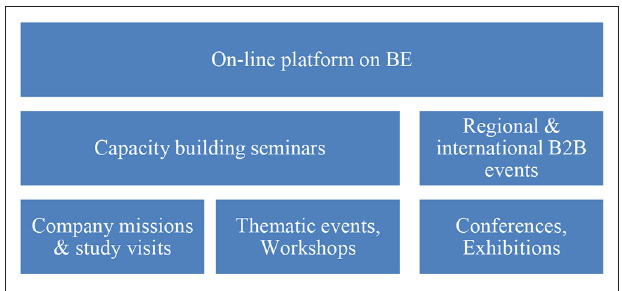
FIGURE 6 | Services provided by each national HUB to its